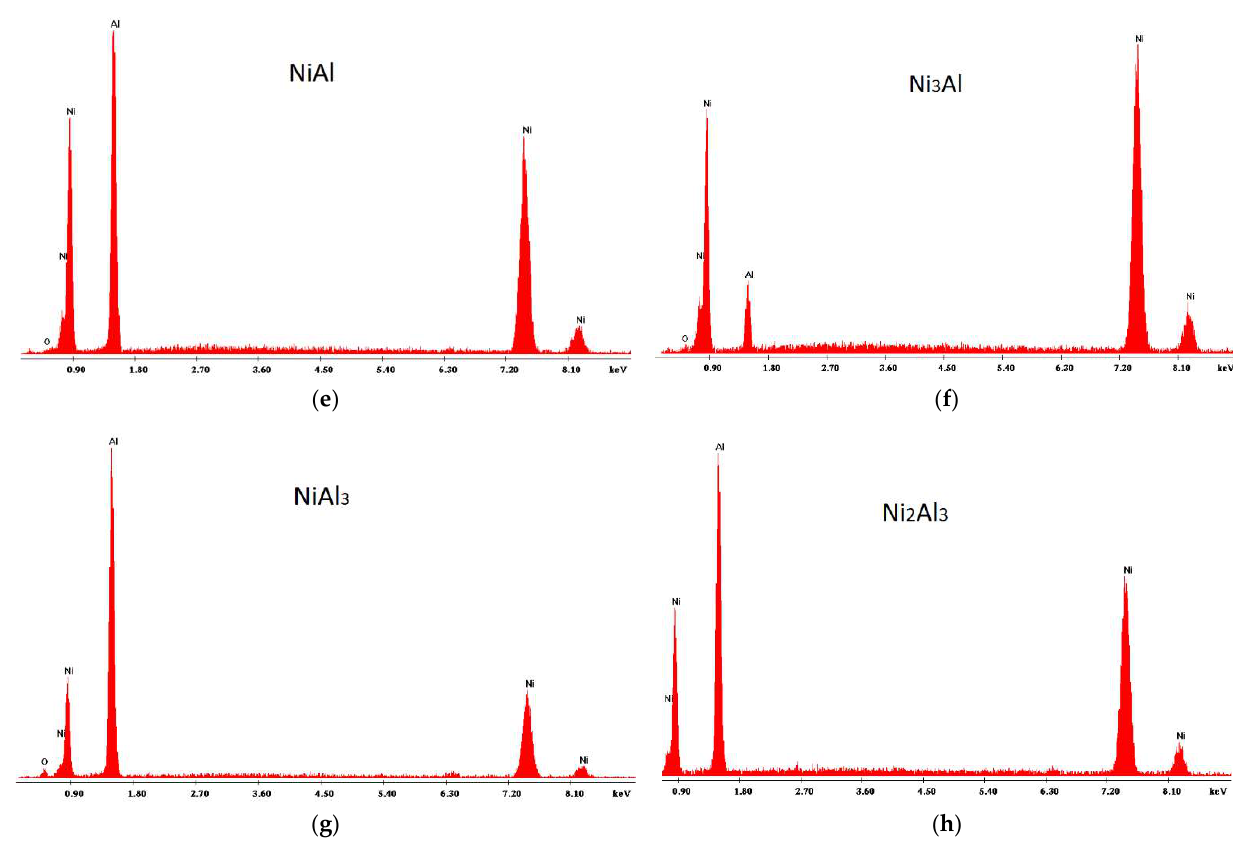
Figure 1. SEM (SE mode) micrographs of coatings (cross-sections) with an initial mixture composition of: ( a ) 42.1% Ni-COMPO 1; ( b ) 59.3% Ni-COMPO 2; ( c ) 65.1% Ni-COMPO 3; ( d ) 86.8%